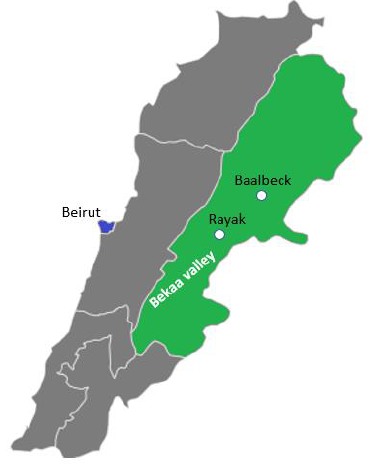
Figure 2. Map of Lebanon.